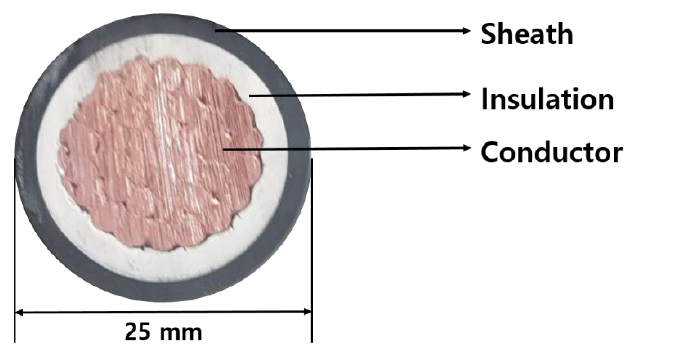
Figure 1. Cross-sectional view of a non-class 1E